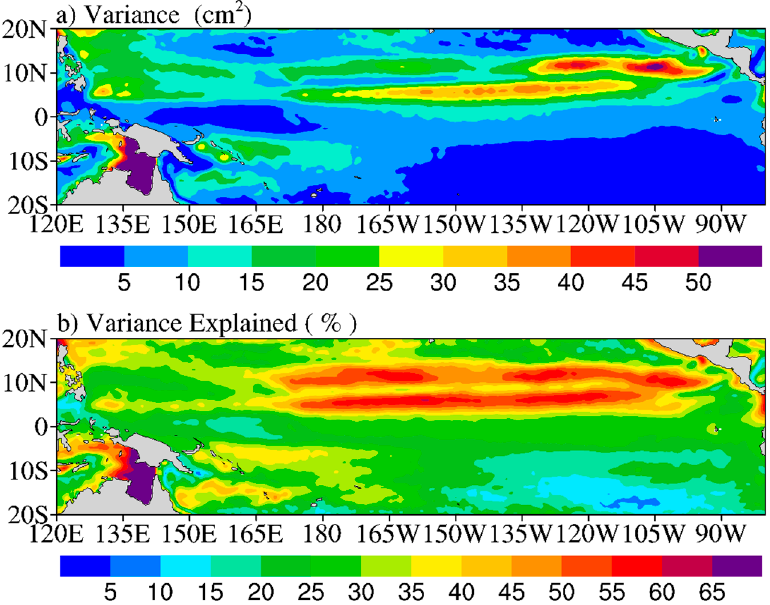
Figure 1. ( a ) The seasonal sea level variances and ( b ) explained variances in the TPO. To explore the contribution of the steric effect and the dynamic process to the seasonal sea level variations in the TPO (Figure 2), we use Equation (1) to calculate the influence of the steric effect and the dynamic process on sea level variations (Figure 2). The steric sea level is calculated using Equation (5), and the dynamic sea level is simulated by a 1.5-layer reduced gravity model.